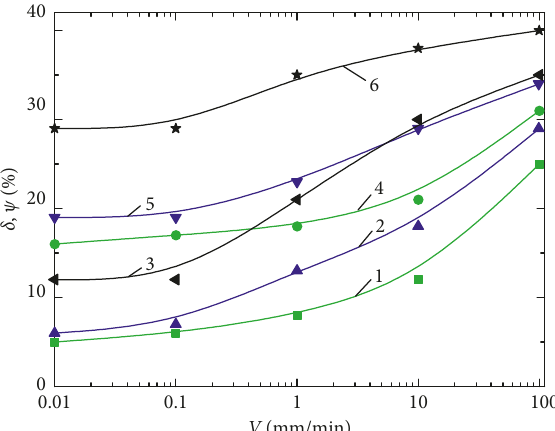
Figure 1: The effect of rising K rate d K /d t on fracture toughness K in hydrogen under pressure 30 MPa of hydrogenated specimens of 20mm thickness. The numbers near to curves correspond to or- dinal numbers in Table 2.